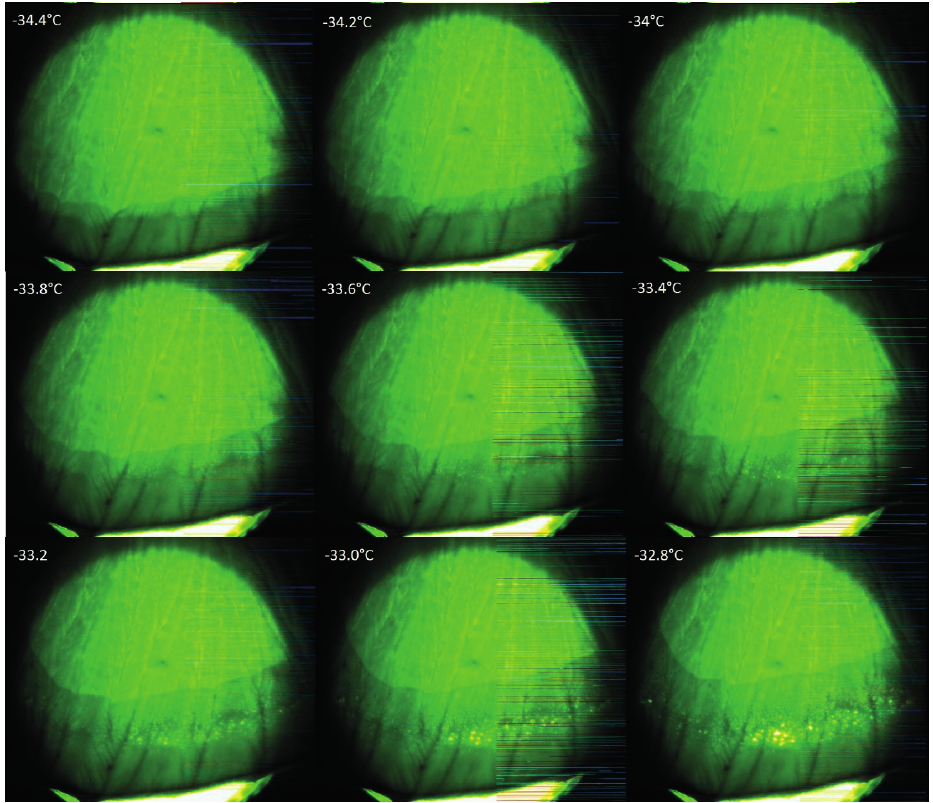
Figure 2. Images obtained at the cryo-microscope, showing the onset of the cake collapse at − 33.4